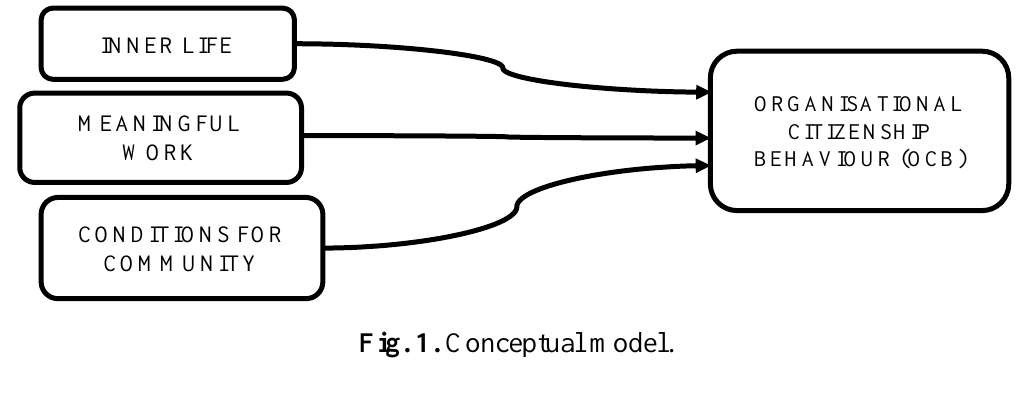
Fig. 1. Conceptual